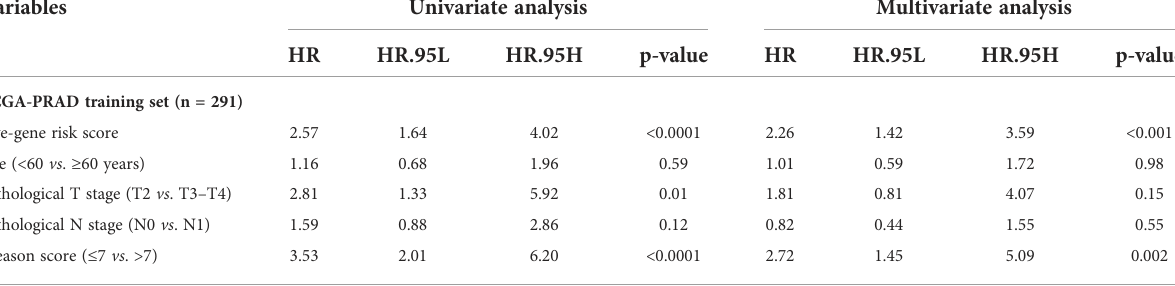
TABLE 3 Univariate and multivariate analyses of the fi ve-gene-based risk score and clinicopathological characteristics in TCGA-PRAD training set (n = 291). Variables